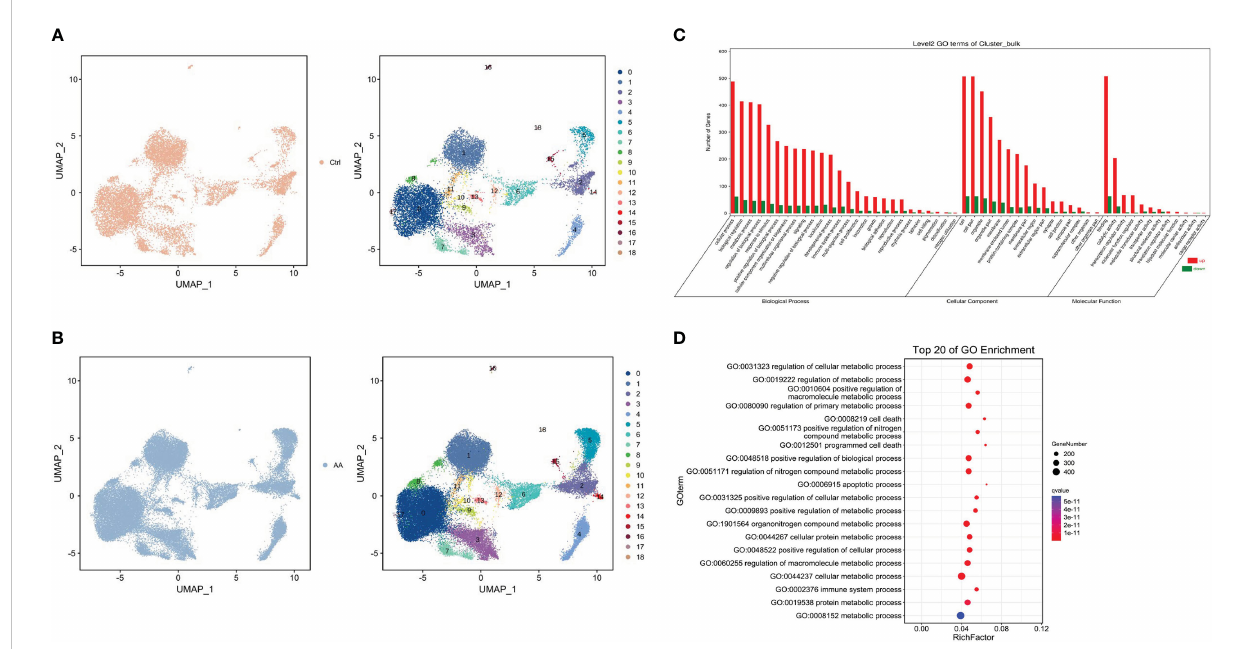
FIGURE 2 Single cell type identi fi cation and enrichment analysis. Uniform manifold approximation and project visualization of the control group (A) and aplastic anemia (AA) (B) based on single-cell transcriptomes (left). Gene Ontology (GO) enrichment classi fi cation histogram depicting the number of up- or downregulated genes in the biological process, cell component, and molecular function ontologies (C) . Dot plot representing top 20 enriched GO terms (ranked by Q values) based on bulk RNA-seq (D)